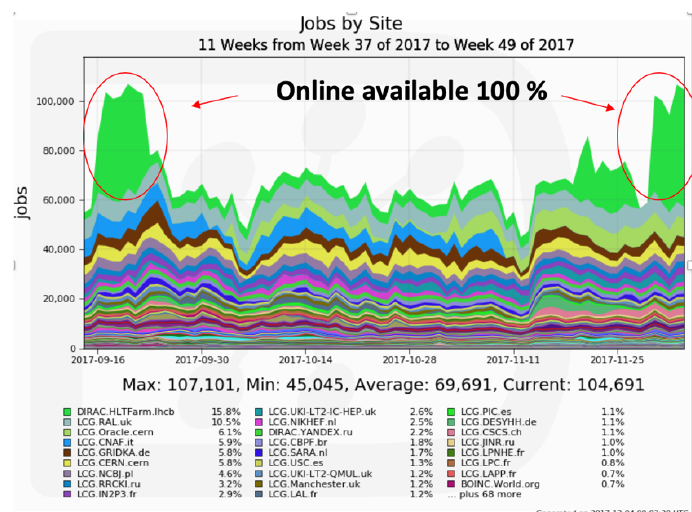
Figure 7. HLT farm CPU days.